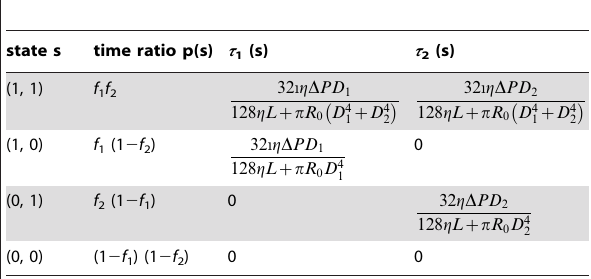
Table 1. Wall shear stress in different